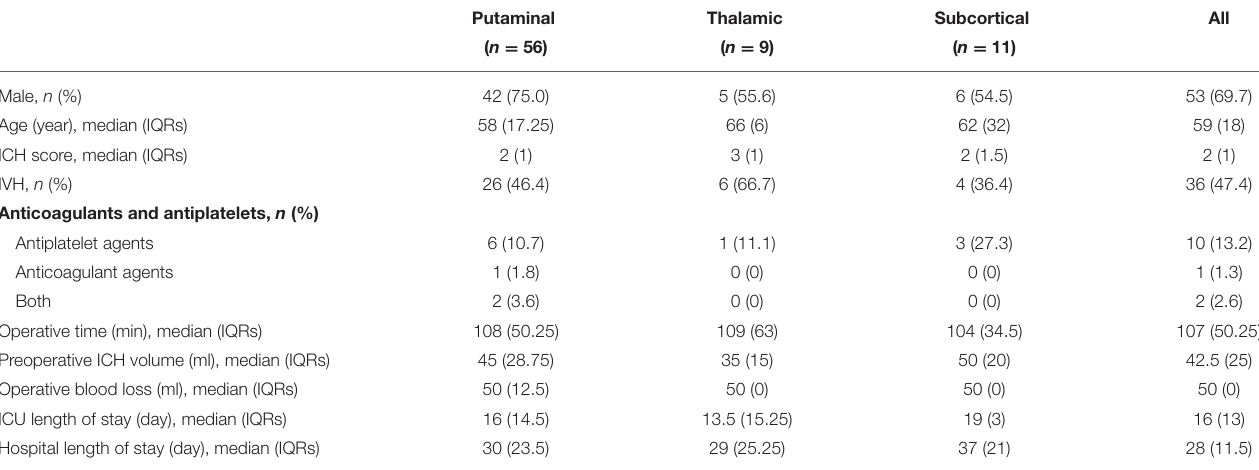
TABLE 1 | Characteristics of patients.